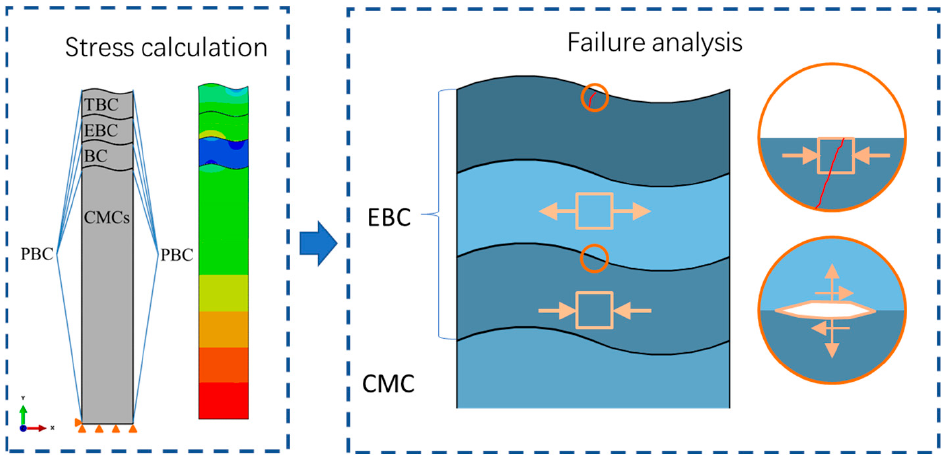
Figure 7. A typical example of the numerical model for the EBC system.